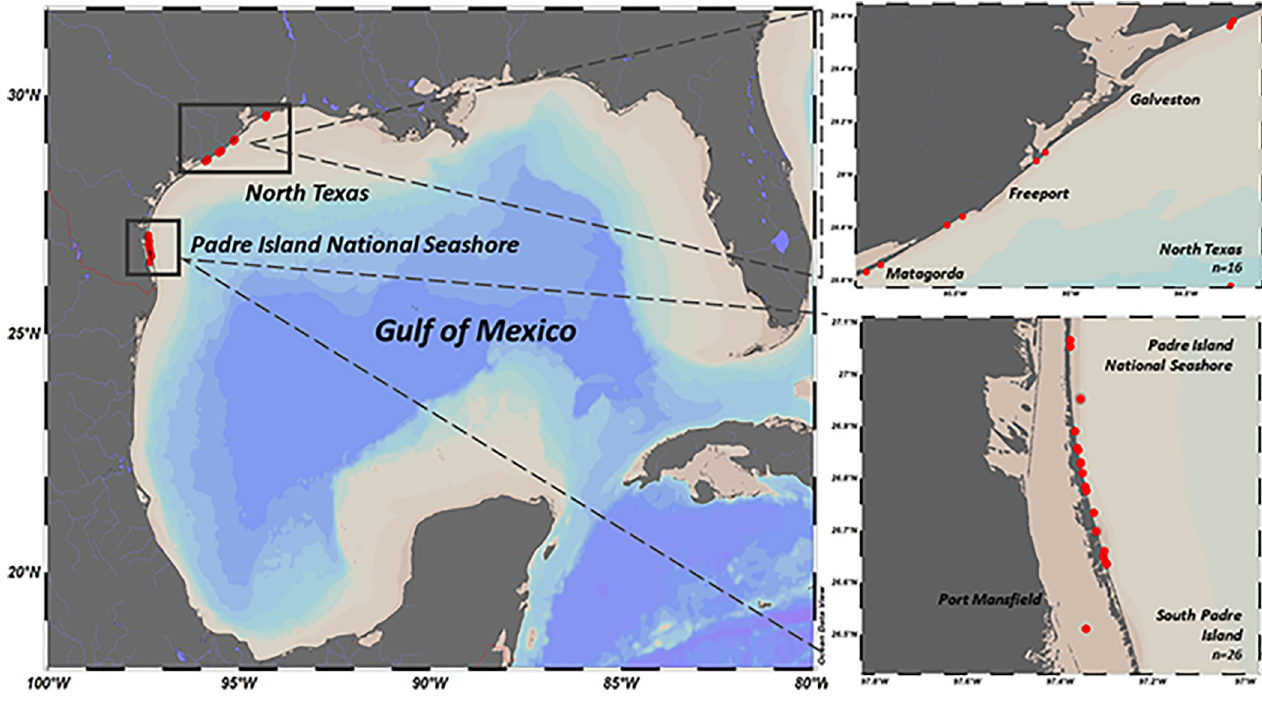
Fig 1. Map of deployment and pop-off locations for PSAT and ADL tagged